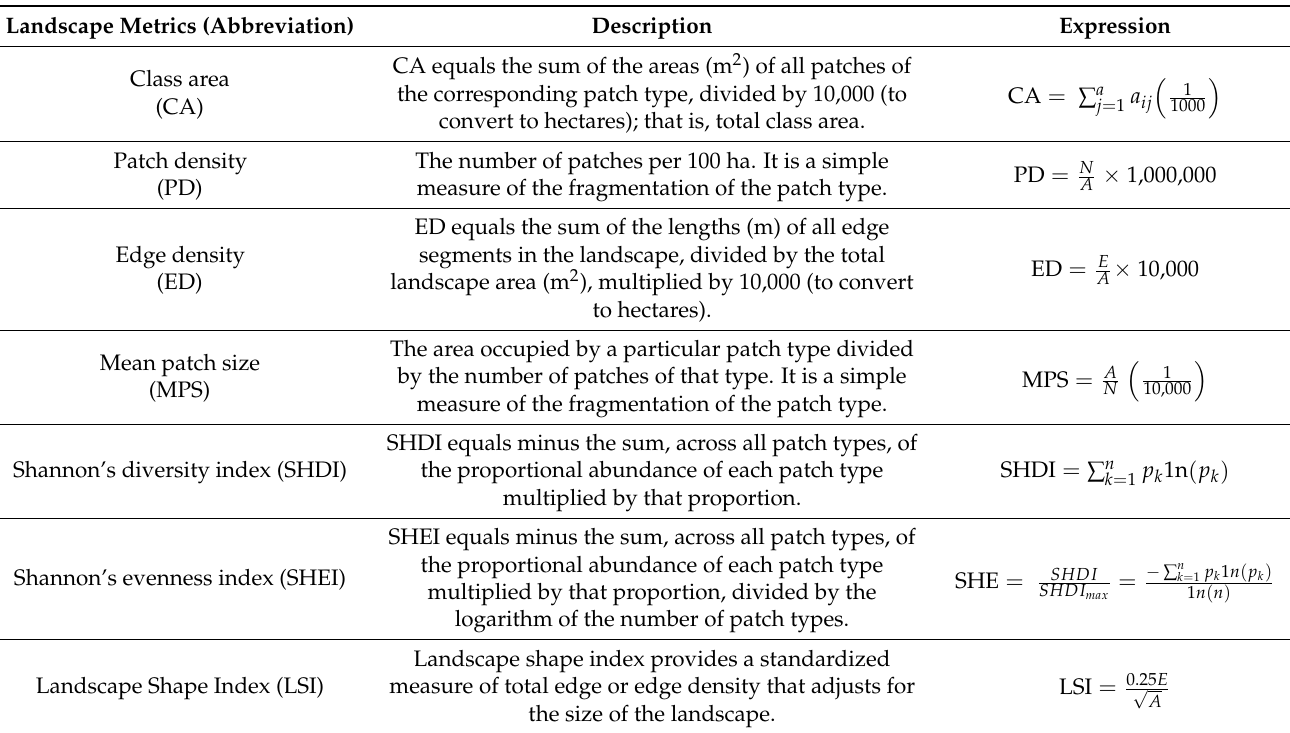
Table 1. Descriptions of landscape metrics